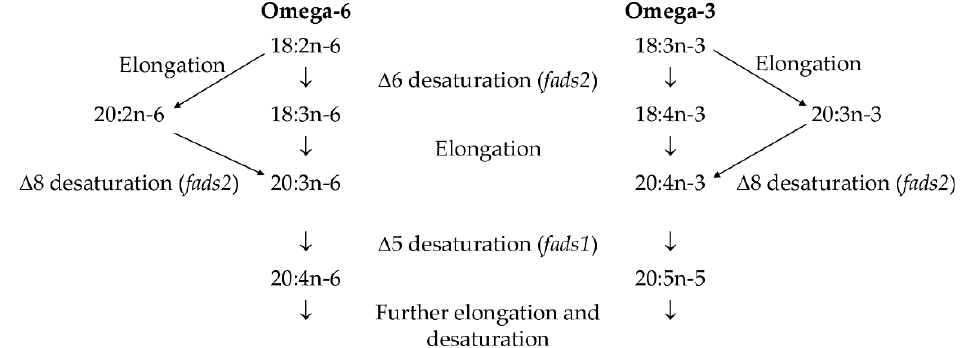
Figure 1. The reaction of ∆ 6 desaturase enzyme, encoded by the fads2 gene, to convert the PUFA precursors to their respective metabolites.